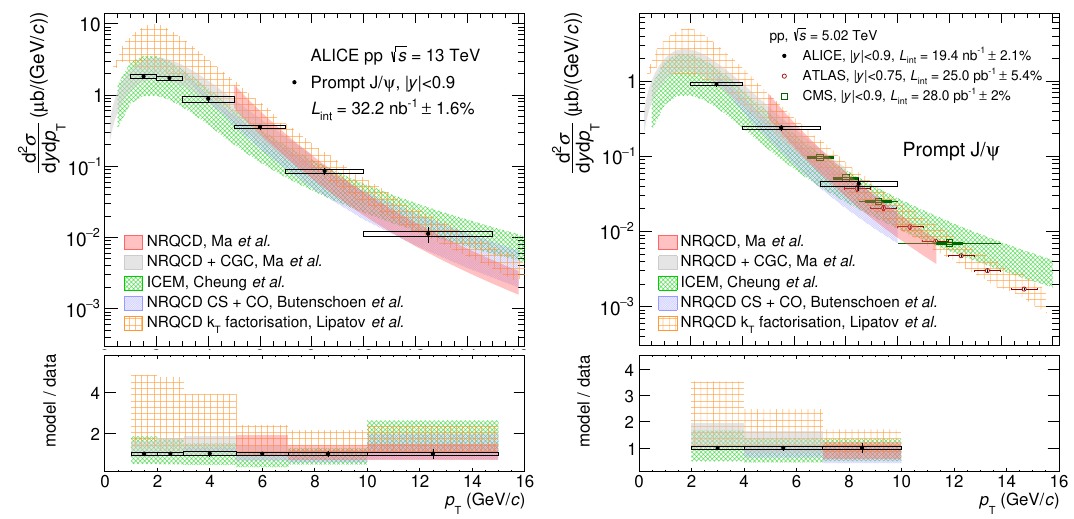
Figure 4 . The d 2 σ of prompt J /ψ measured by the ALICE collaboration in pp collisions at d y d p T √ √ s = 13 TeV (left panel) and s = 5.02 TeV (right panel). The error bars (boxes) represent √ the statistical (systematic) uncertainty. The results at s = 5.02 TeV are compared with similar measurements from CMS [17] and ATLAS [16] at high p T . Uncertainties due to the luminosity are not included in the boxes. The results are compared with calculations from NLO NRQCD [43, 44, 90], NRQCD+CGC [91], and from ICEM [38]. Bottom panels show the ratios of the models to ALICE results. The uncertainty bands represent the relative uncertainty from each model whereas the bars and boxes centered around unity refer to relative statistical and systematic uncertainties on ALICE data points,